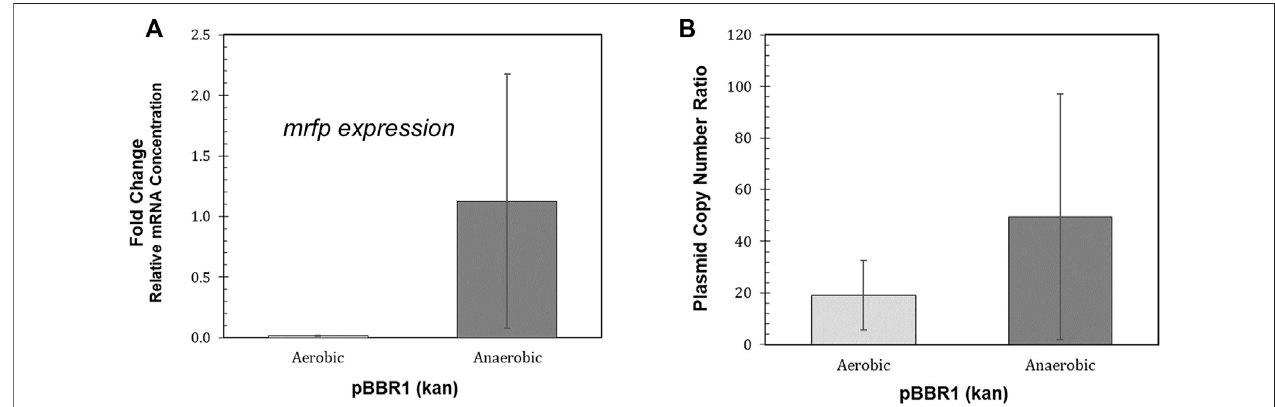
FIGURE5| Performanceofthe R.palustris BBR1-kan-mRFPstrainduringphototrophicgrowth. (A) RelativemRNAconcentration( mrfp relativeto 16rRNA )forthe R.palustris BBR1-kan-mRFPstrainwhengrownaerobicallyinthedarkandanaerobicallyinthelight(100 µEwhitelight)(MaterialsandMethods).Twobiologicalandtwo technical replicates were averaged for each strain. Error bars represent the population standard deviation. (B) Average plasmid copy number for the R. palustris BBR1- kan-mRFP strain grown aerobically in the dark and anaerobically in the light (100 µE white light) in duplicate. Copies of the kanamycin selection marker gene was compared to the single copy dxs gene in the chromosome by qPCR and an external standard curve (Materials and Methods). Error bars represent the population standard deviation.